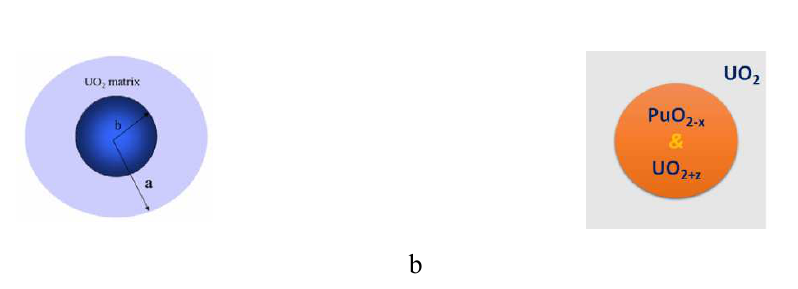
Figure 3: Spherical cell model for the PuO /UO system as in [2] (a) and in a current work (b). 2 2 Computed parametrical dependences have been represented by an exponentiation with a temperature as a basis and an exponent dependent on which kind of resonances form reactivity feedback. In our case major influential cross section in matrix and in Pu-rich zones are